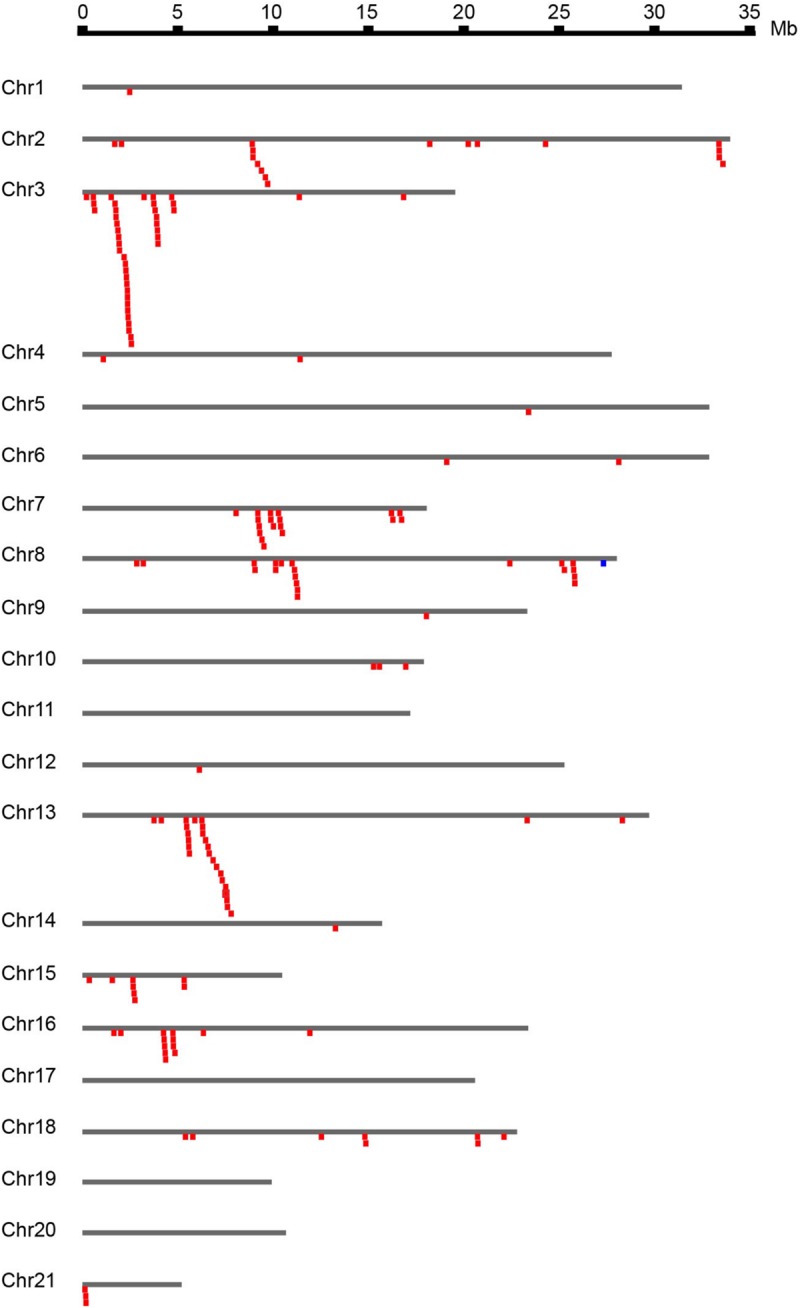
Chromosomal distribution of D. rotundata NBS-LRR genes. The 167 identified NBS-LRR genes are plotted against the D. rotundata chromosomes based on their physical locations retrieved from the GFF3 file. NBS-LRR genes within an interval of less than 250 kb were treated as a cluster (Ameline-Torregrosa et al., 2008).